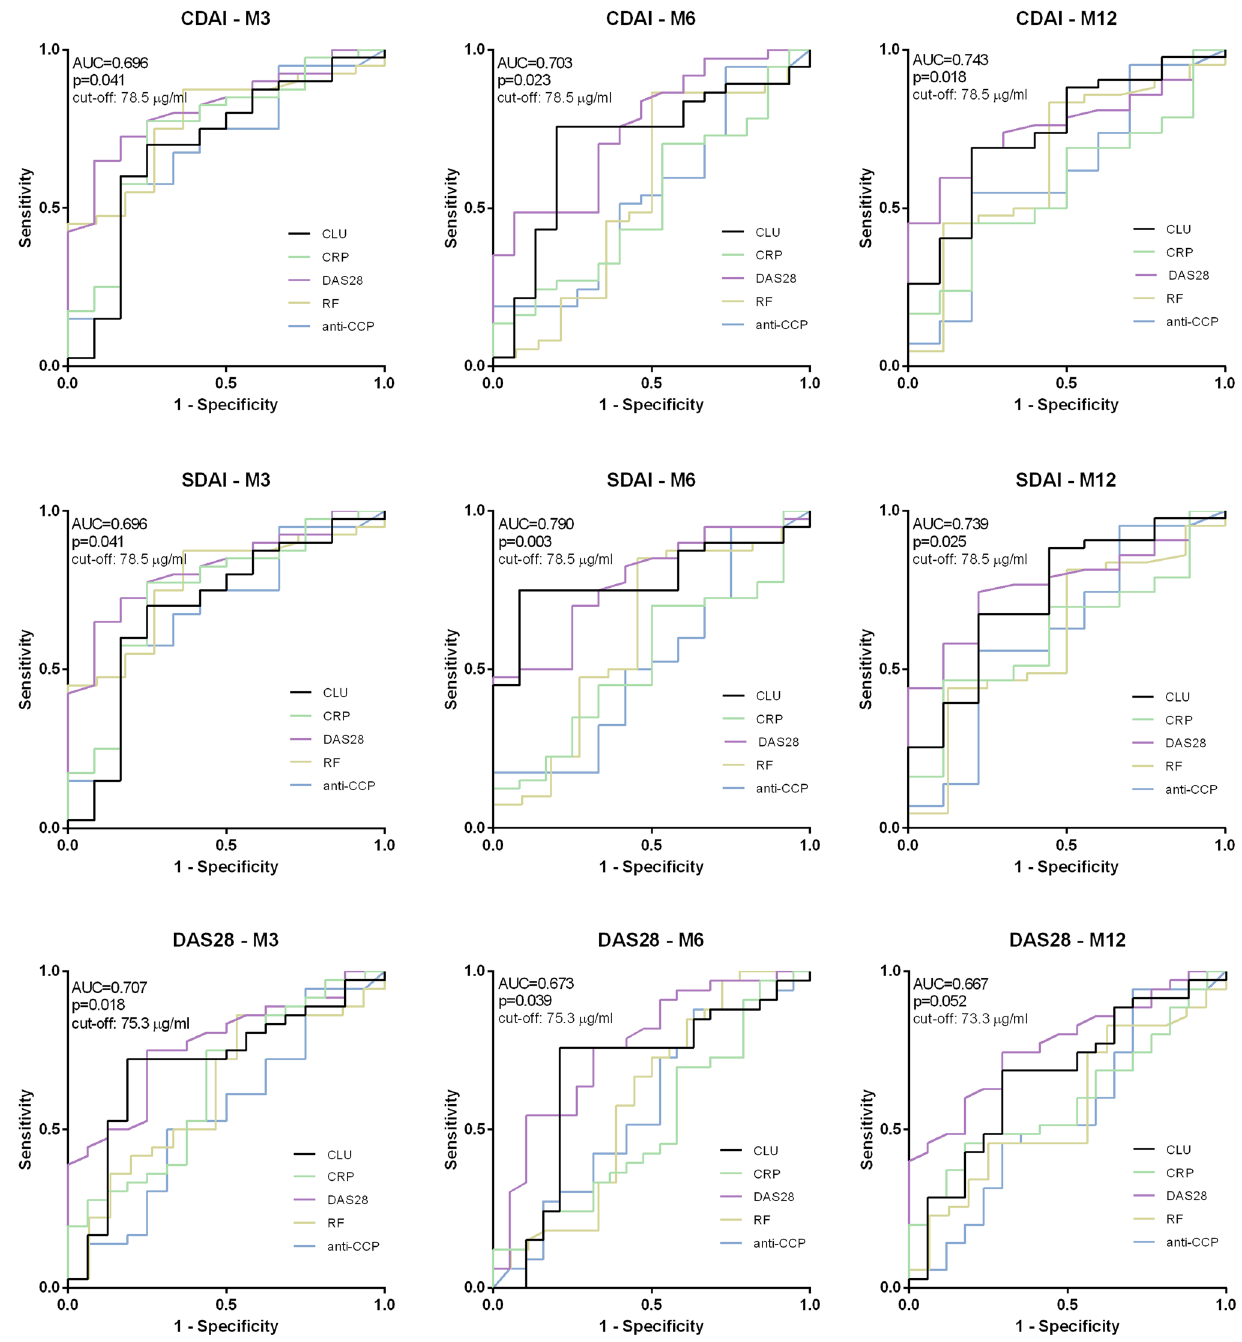
Figure 3. ROC curve analysis of baseline CLU levels, DAS28, RF, anti-CCP and CRP levels for prediction of achieving low disease activity or remission after 3, 6 and 12 months of treatment according to the CDAI, SDAI and